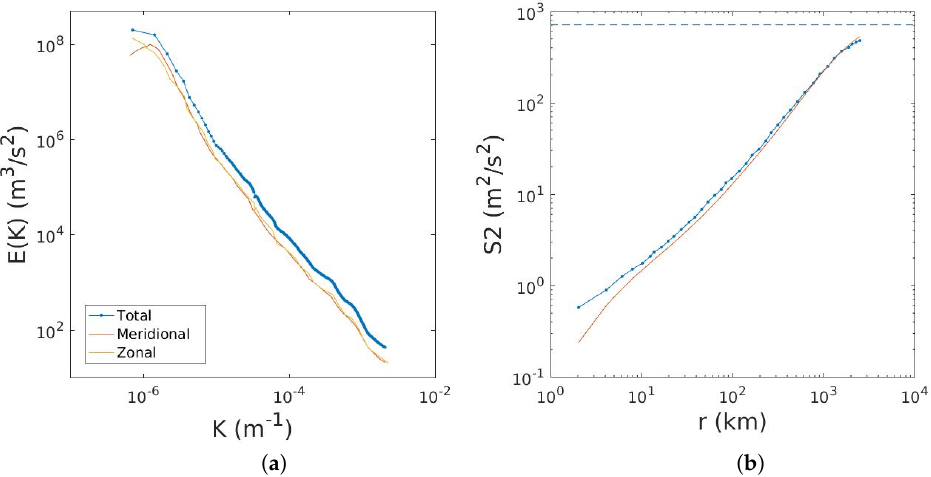
Figure 3. The zonal, meridional and total energy spectra extracted from Figure 3 of [18] (( a ) panel). The 2D longitudinal structure function calculated from the zonal energy spectrum is shown by the solid curve in the ( b ) panel. Also shown is the structure function (dotted curve) calculated from data, obtained from Figure 3 of [26]. The dashed horizontal line is the twice the zonal energy, calculated from integrating the zonal spectrum. Reproduced with